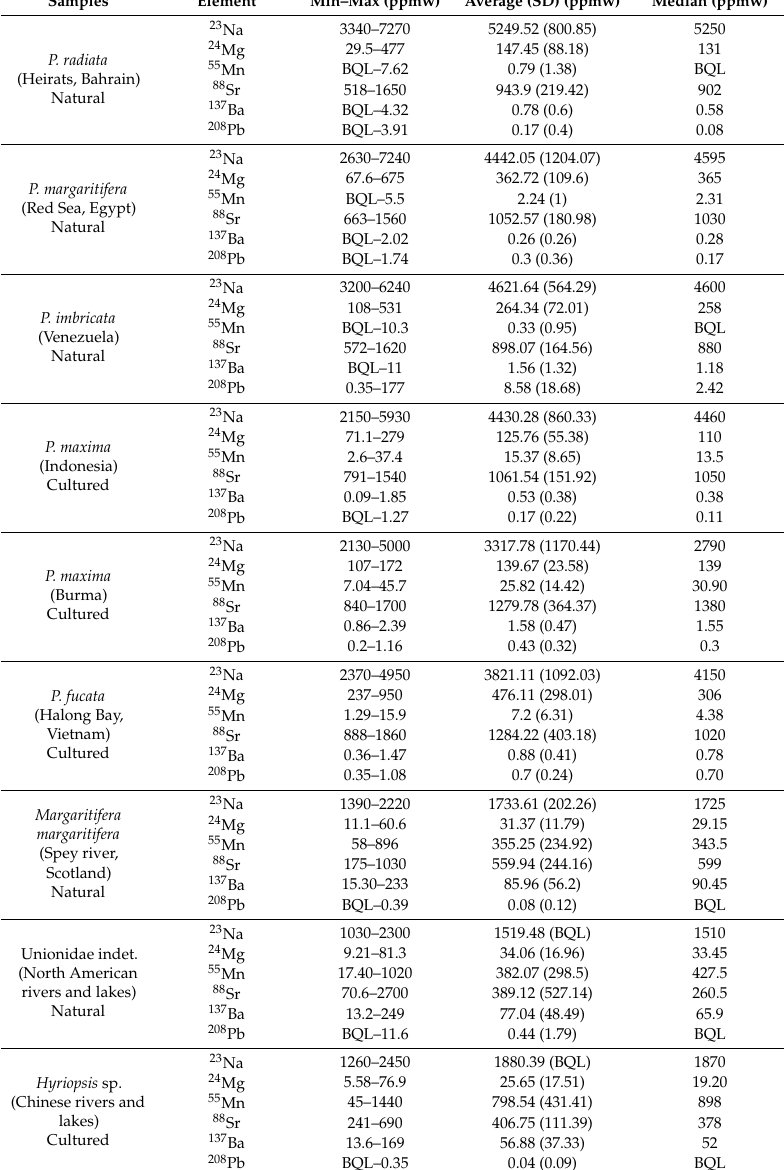
Table 4. LA-ICP-MS analysis of the studied samples by